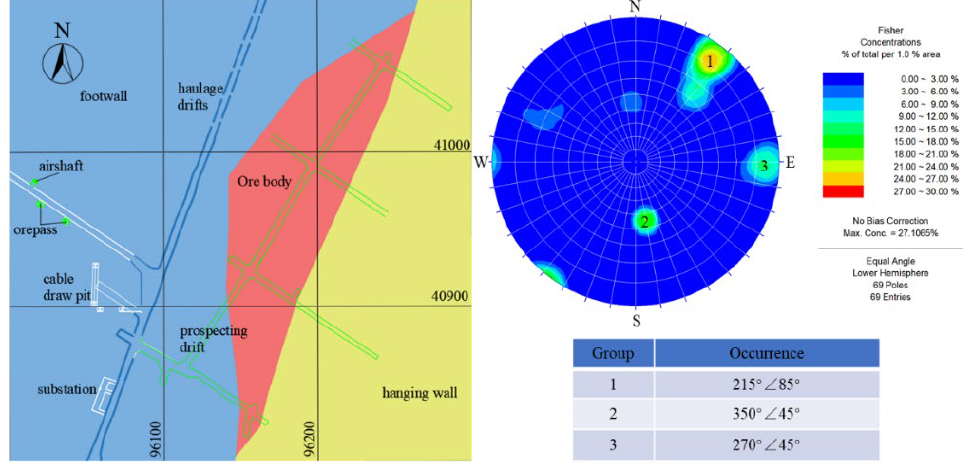
Figure 10. Survey joint occurrence in prospecting drift and determination of dominant joints with Dips software.